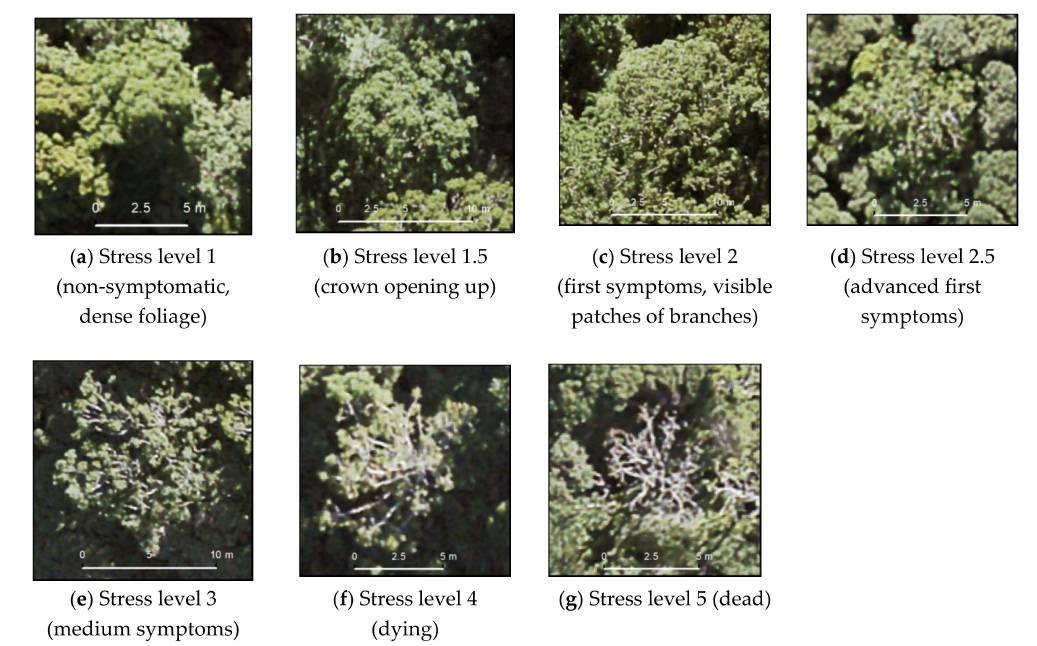
Figure 4. Aerial images from ( a ) non-symptomatic kauri, several states of decline in kauri crowns ( b–f ), to ( g ) dead trees. All crowns are of a medium size (mean diameter: 4–12.2 m)